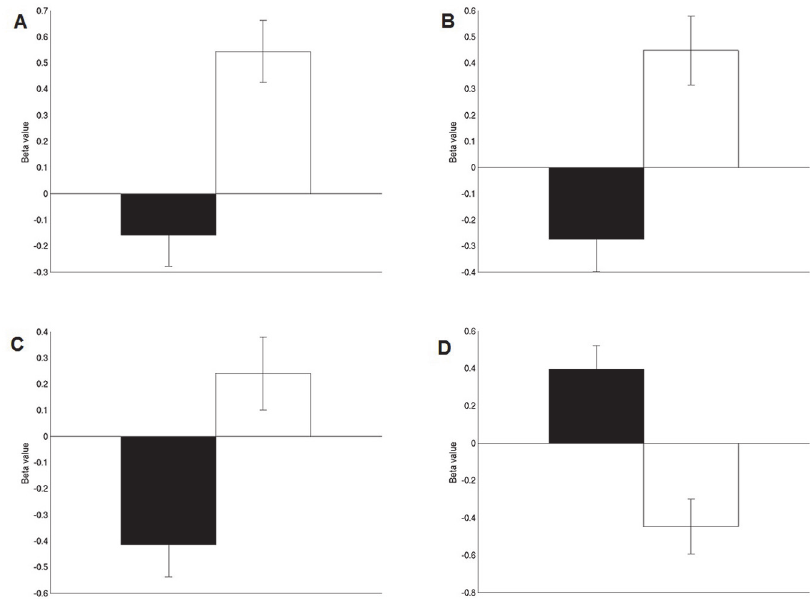
Fig 4. Bar plots showing mean activation levels ( ‘ beta weights ’ ) of each of the regressors (Mentalizing in black, Action in white) against baseline, in each of the regions found in the whole-brain analysis (Fig. 3). A ) left superior temporal gyrus. B ) right superior temporal gyrus. C ) posterior cingulate cortex. D ) anterior medial prefrontal cortex. Error bars represent standard error of the mean (s.e.m.).